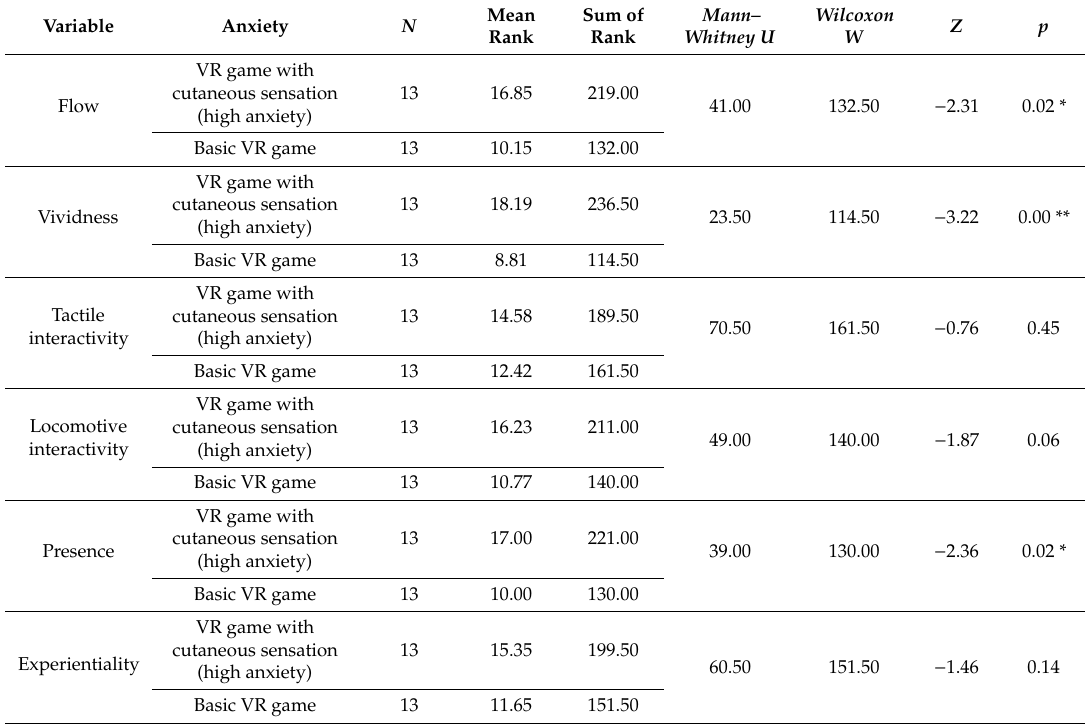
Table 7. Results of the Mann–Whitney U test analysis for the variables of the high-anxiety group while playing the fire safety education VR game with cutaneous sensation and the group that played the basic fire safety education VR game.